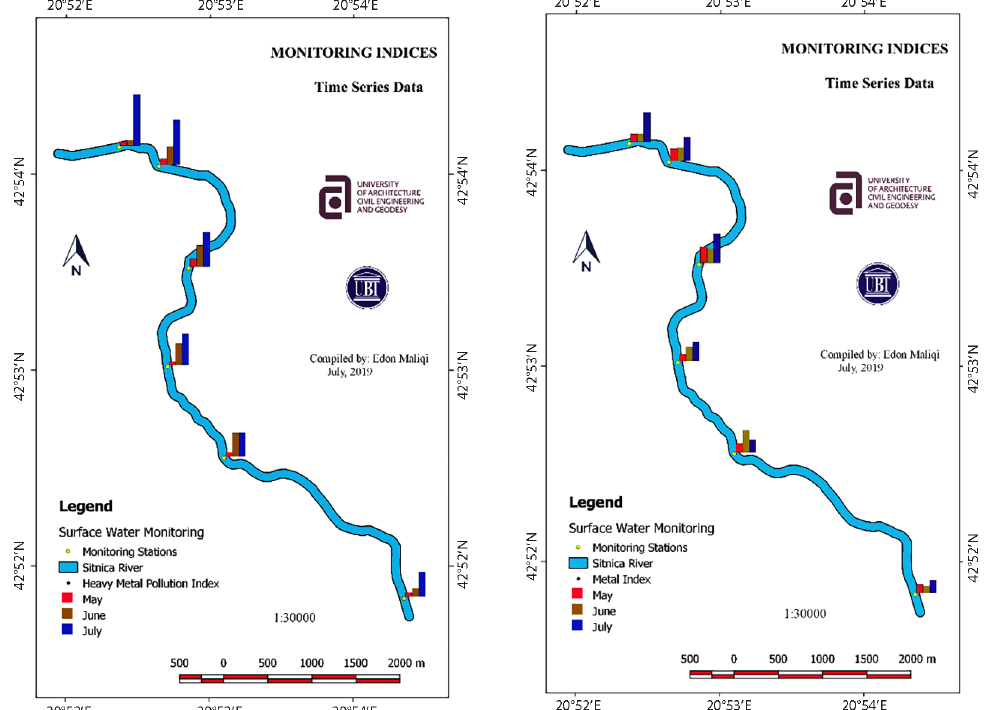
Figure 7. The histogram maps for level and distribution (HPI and MI,